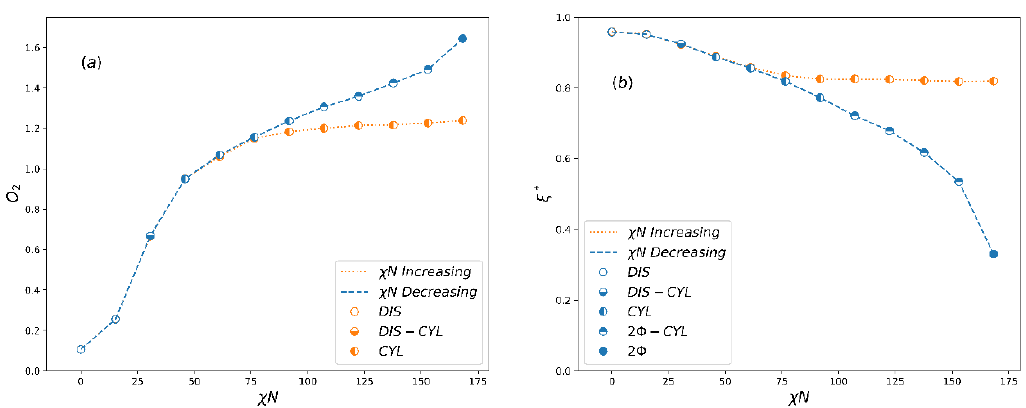
Figure 10. ( a ) The averaged order parameter, O 2 , and ( b ) the normalized extent of reaction, ξ ∗ , as a function of χ N , for A3B7 SDC system. DIS-CYL denotes a coexistent phase.